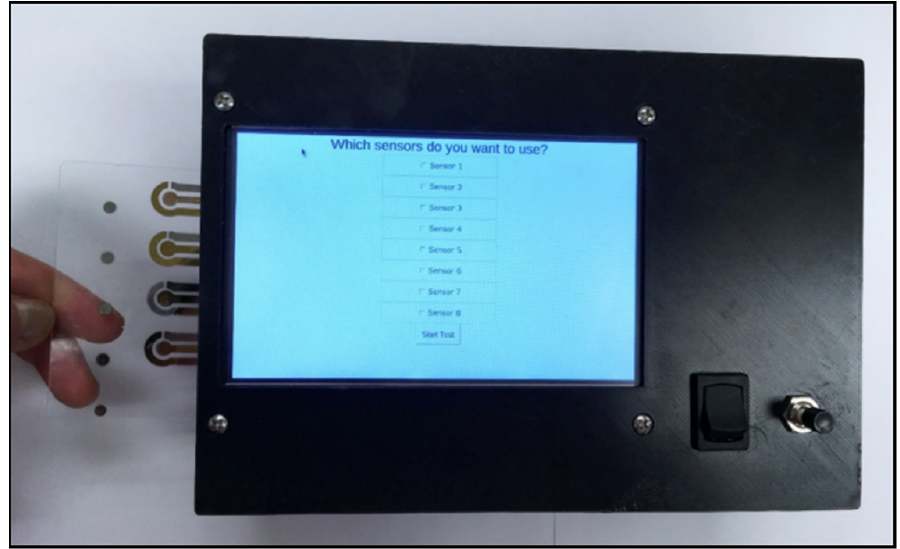
Figure 1. The µDrop system from Khetani et al. designed to perform differential pulse voltammetry to quantify C-tau and NF-L. Reprinted with permission from [36]. Elsevier 2021. FET-based biosensors are a specific type of potentiometric electrochemical biosensor. These sensors consist of a source and a drain connected by a gate. Typically, antibodies for an analyte of interest are conjugated on the gate, and the gate voltage is affected by the concentration of the analyte bound to the antibodies [86]. Song et al. developed an organic field effect transistor (OFET) for measuring GFAP [49]. The design featured an extended solution gate achieved by incorporating polyethylene glycol (PEG) into the antibody layer to extend the Debye screening length (distance beyond which voltage changes are not sensed) (Figure 2). The extended gate allows the sensing area to be separated from the organic semiconductor and to work without a reference electrode, simplifying and stabilizing the sensor. However, the LLOD of the sensor was only 1 ng/mL, above the cutoff for a mTBI (GCS 13–15). Huang et al. designed an organic thin film transistor (a special type of metal-oxide semiconductor field-effect transistor (MOSFET)) for GFAP consisting of both p-channel and n-channel semiconductors to enable identification of electrical crosstalk and false-positives [45]. The LLOD was the same as the device from Huang et al. at 1